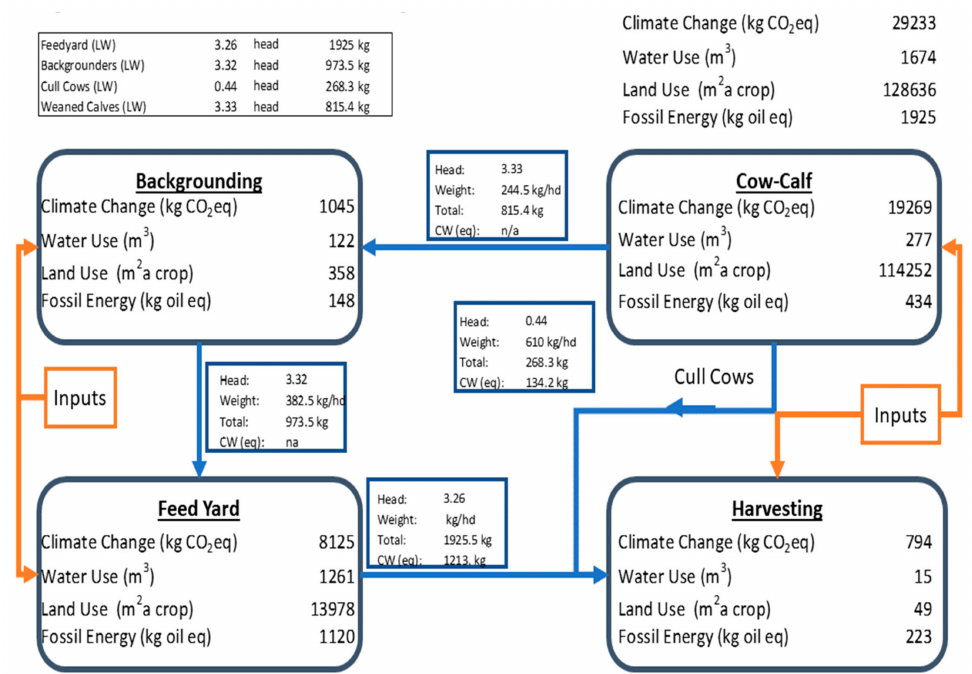
Figure 2. Base case for 1000 kg of retail cuts. Truncated BG; Full FY; Enogen